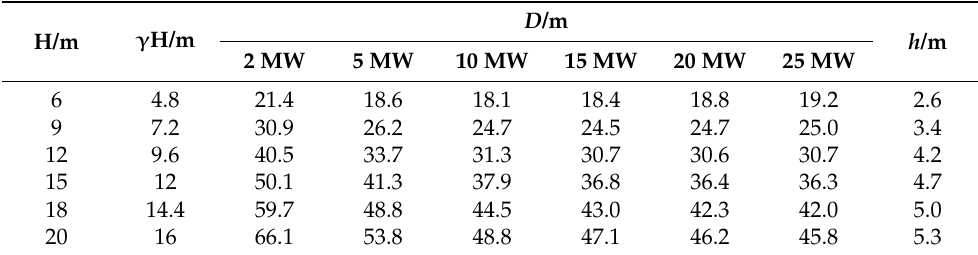
Table 2. The value of the temperature field division parameter.